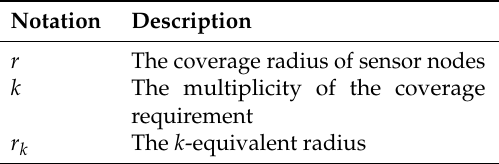
Description of the main notations. Force